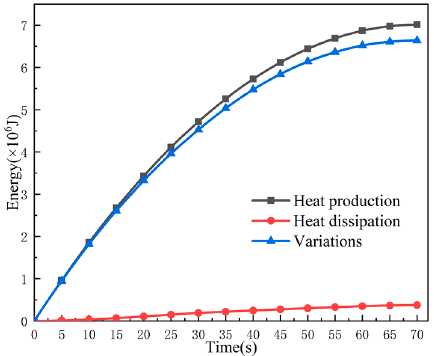
Figure 19. Heat production–heat dissipation curve with